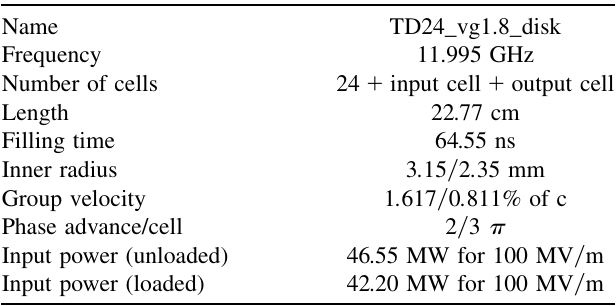
TABLE II. Main parameters of the CLIC prototype accelerator structure installed in the Two-beam Test